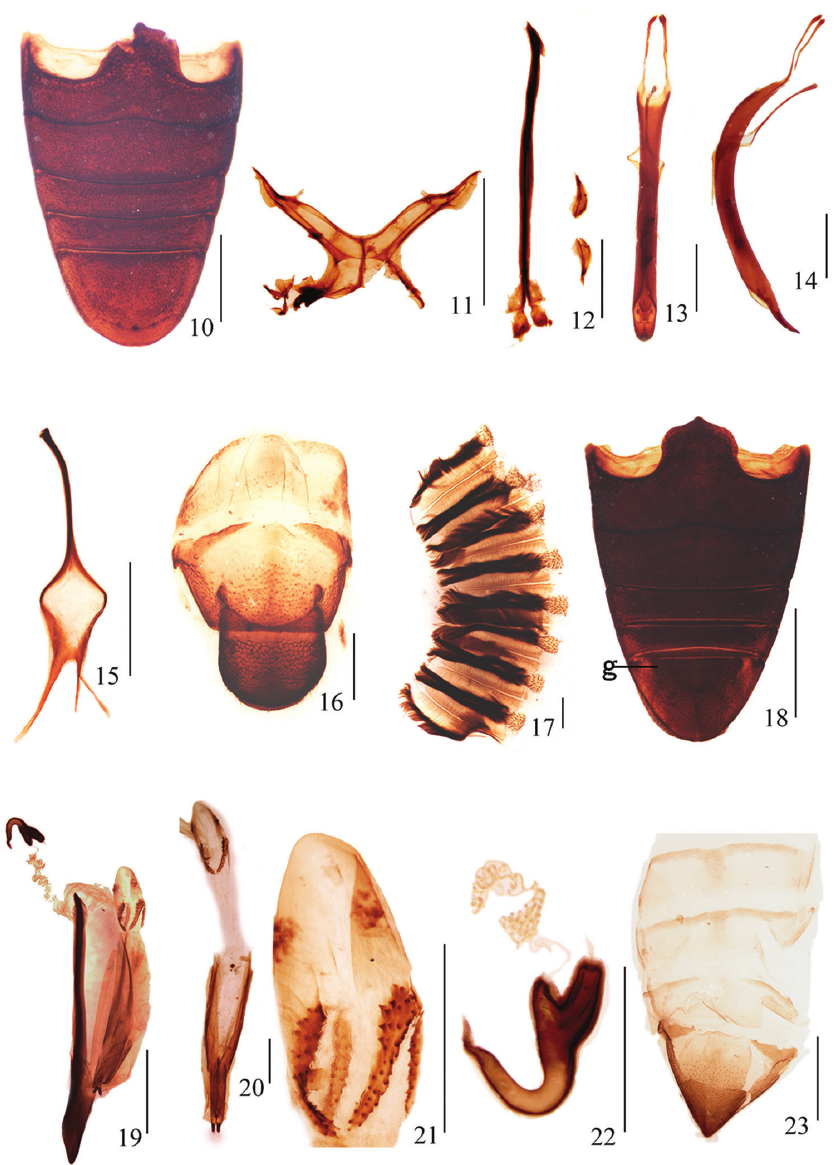
Figures 10–23. Abdominal and genital structures of Leptomias verticalis sp. n.: 10 male paratype, ven- trites, ventral view 11 male paratype, metendosternite, dorsal view 12 male paratype, sternites VIII and IX, dorsal view 13 male paratype, aedeagus, dorsal view 14 male paratype, aedeagus, lateral view 15 male paratype, tegmen, dorsal view 16 male paratype, pygidium, dorsal view 17 male paratype, proventriculus 18 female paratype, ventrites, ventral view (g - laterobasal groove) 19 female paratype, sternite VIII and genitalia, lateral view 20 female paratype, gonocoxites and styli, dorsal view 21 female paratype, bursal sclerites, dorsolateral view 22 female paratype, spermatheca, lateral view 23 female paratype, pygidium, dorsal view. Scale bars 10–19, 23 : 1 mm; 20–22 : 0.5